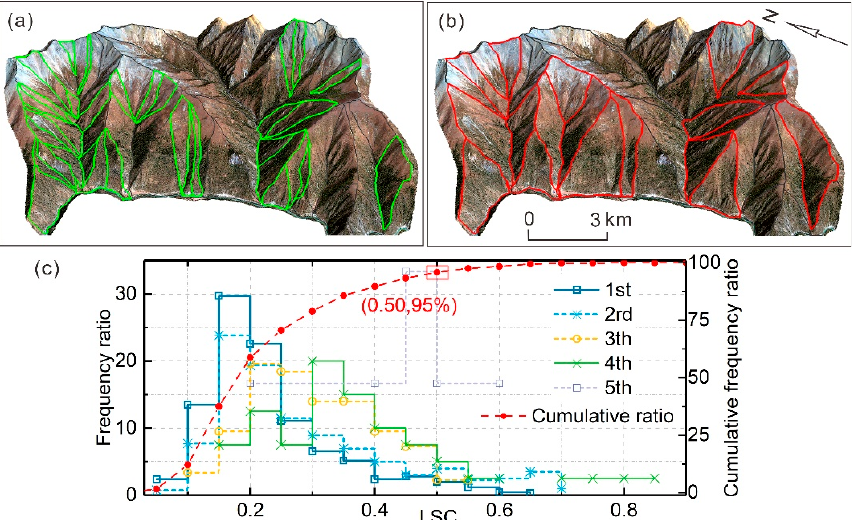
Figure 9. Process of determining the referenced threshold from the simulation merging process. ( a )